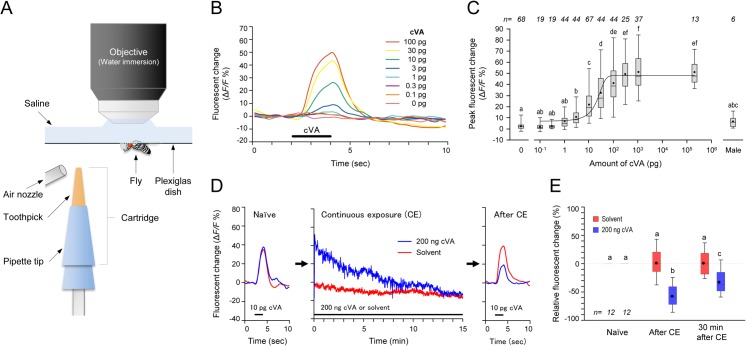
Dose-dependent cVA response and desensitization by prolonged stimulation in Or67d ORNs.(A) Odor stimulation system with in vivo imaging of neural responses in the DA1 glomeruli (see Methods and S3 Fig). Neural responses to cVA were monitored with a fluorescent microscope upon odor stimulation. cVA was applied on the toothpick of the cartridge and an air puff from the air nozzle delivered the volatilized cVA to the antennae of the fly. (B) Representative fluorescent changes evoked by odor stimulation of various amounts of cVA (0 to 100 pg in this case) in a male fly. (C) Peak fluorescent changes in response to cVA and a live male. Peak values of the transient fluorescent change in response to odor stimulation are shown as box plots representing 25th, 50th, and 75th percentiles with whiskers from minimum to maximum and circles (mean). A logistic curve was plotted based on mean values of the peak fluorescent changes in each amount of cVA (see Methods). EC50 is 27.5% in 22.3 pg cVA. Odor stimulation using a live male is shown in S4 Fig. (D) Representative neural responses to 10 pg cVA of the Or67d ORNs before (Naïve) and after continuous exposure (After CE) to 200 ng cVA (blue) or hexane solvent control (red) for 15 minutes. During the 15 minutes CE, the response to 200 ng cVA was decreased and thereafter the acute response to 10 pg cVA also decreased. (E) Peak responses to 10 pg cVA before (Naïve), immediately after (After CE), and 30 minutes after the continuous exposure (30 minutes after CE).